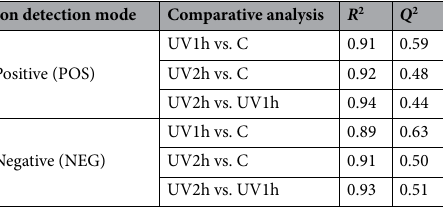
Table 3. Parameters of projections to PLS-DA models on the basis of different comparative analyses. PLS-DA partial least squares-discriminant analysis, UV ultraviolet.